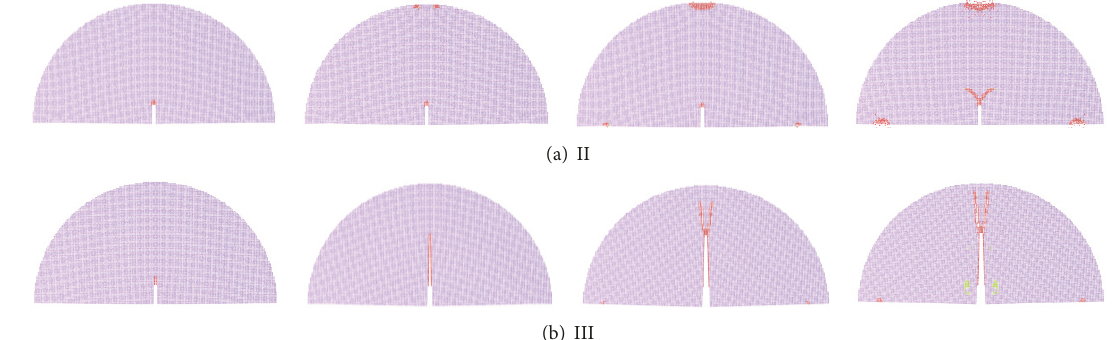
Figure 20: Numerical results for different